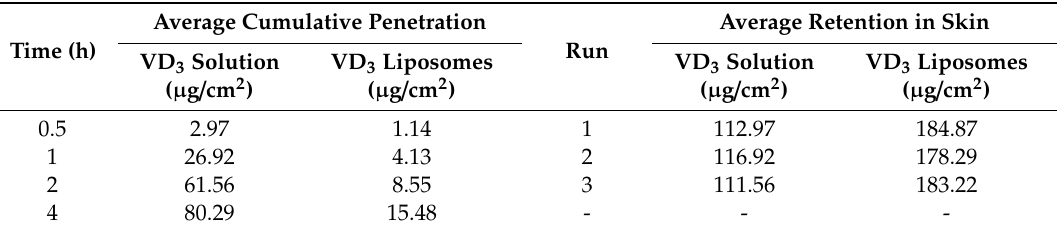
Table 7. Average cumulative penetration and retention of VD 3 in the